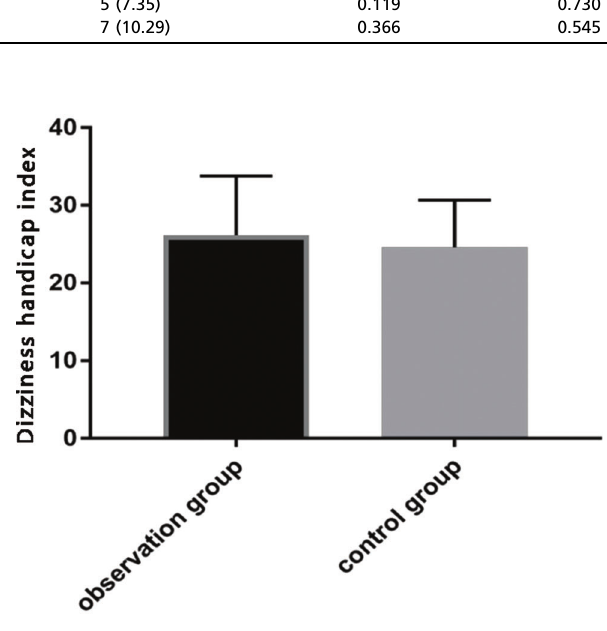
Figure 1 - Vestibular symptom index (VSI) score after treatment. After treatment, the VSI score in the observation group was significantly lower than that in the control group (t=5.719, p o 0.001).